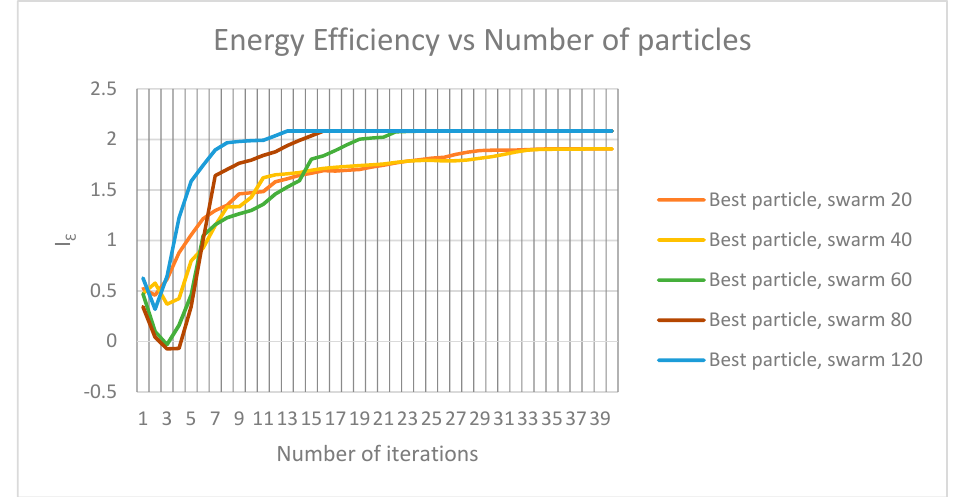
Figure 3. Differences in the behavior regarding the number of particles.